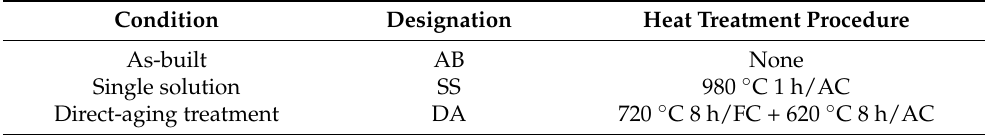
Table 3. The specific heat treatment in this